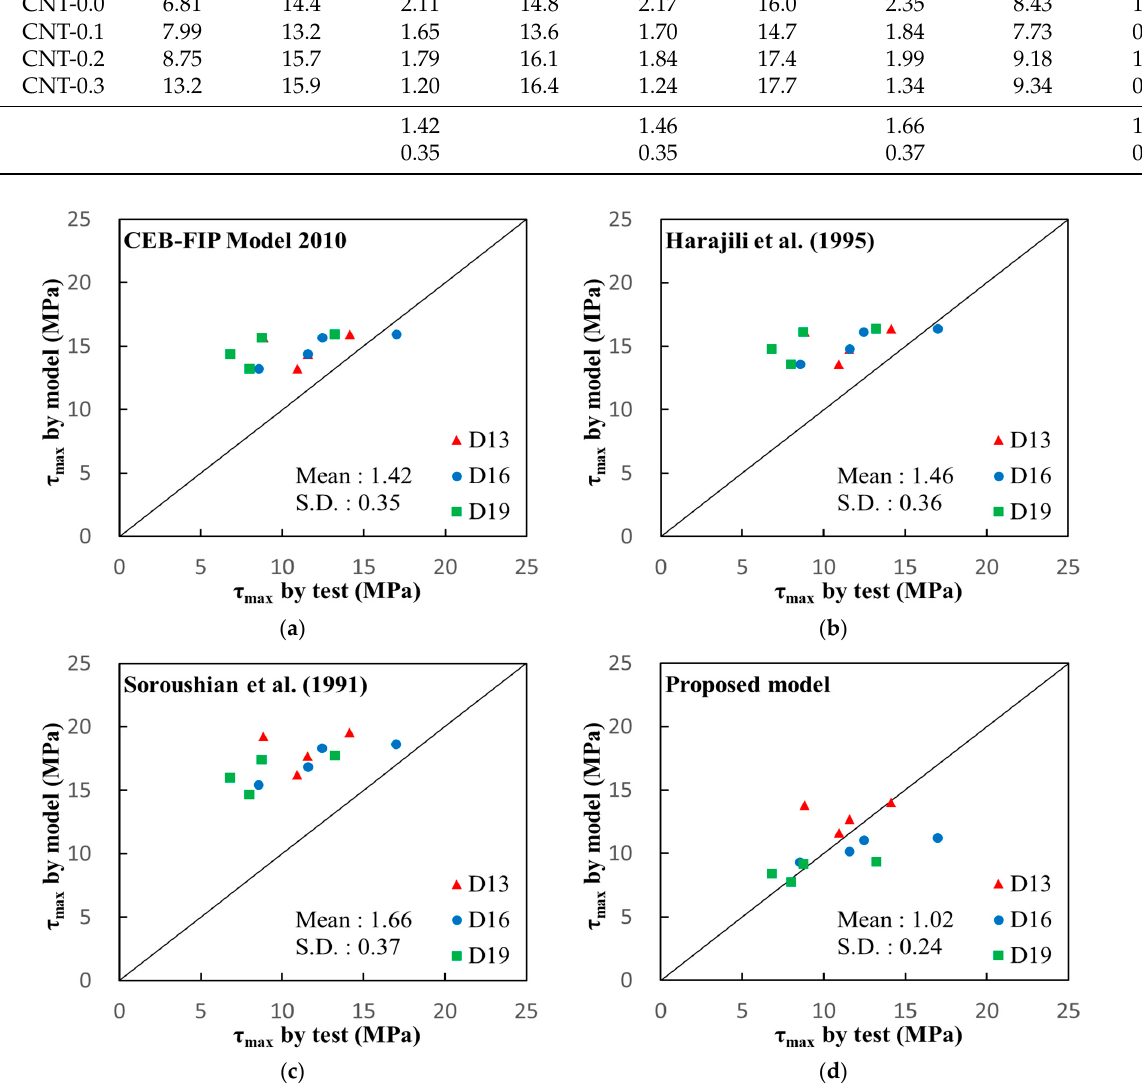
Figure 12. Comparison of the test results and the models on the bond strength of rebar embedded in PVA cementitious composites with CNTs: ( a ) CEB-FIP Code Model 2010 [37] ( b ) Harajili et al. (1995) [36] ( c ) Soroushian et al. (1991) [34] ( d ) Proposed Table 8. Comparison on the bond strength between the test results and the models.